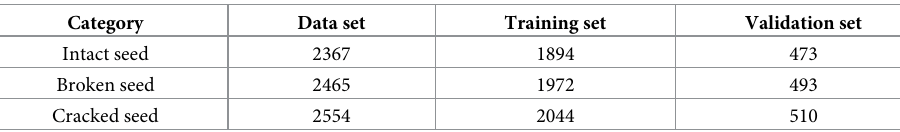
Table 1. Cotton seed